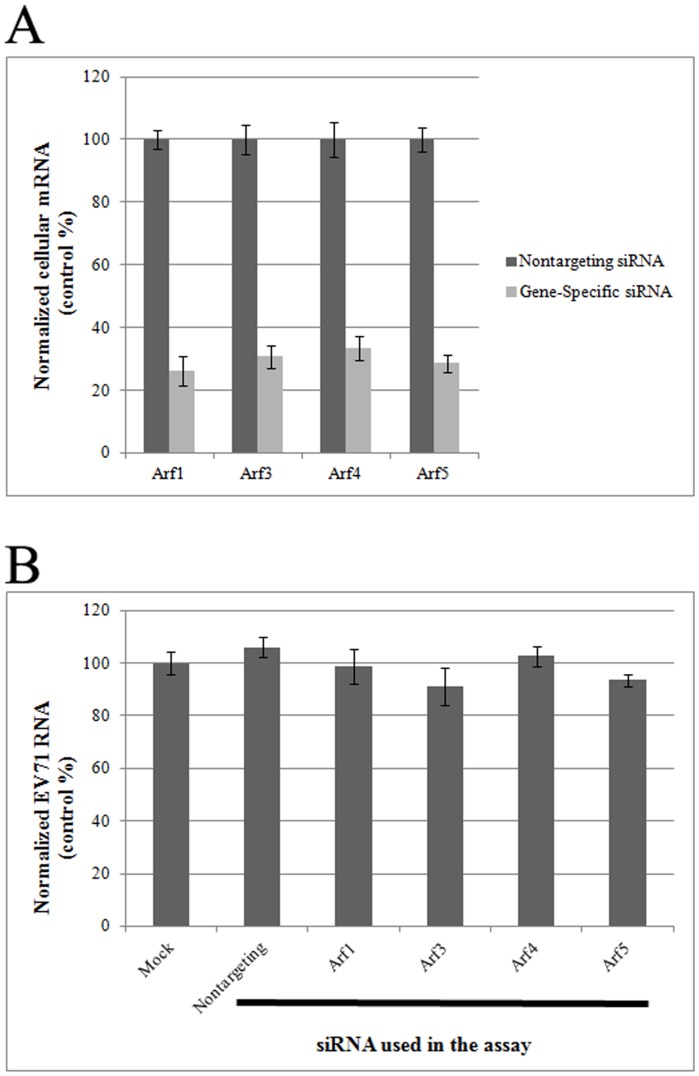
Knockdown of a single Arf does not affect EV71 replication in cells.(A) Individual Arf isoforms were effectively knocked-down with siRNAs (P<0.05). (B) Knockdown of a single Arf did not affect EV71 replication in cells (P>0.05).